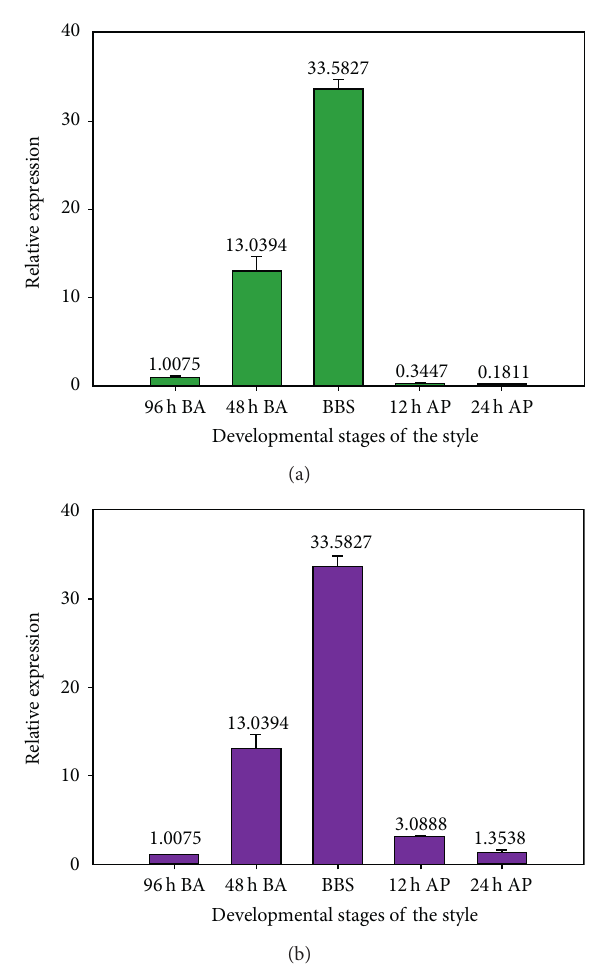
Figure 7: QPCR analysis for the PbS -RNase gene expression 26 detection during styles development in “Hongpisu.” (a) Relative -RNase gene in the style before and after self- expression of the PbS 26 -RNase gene in the pollination; (b) relative expression of the PbS 26 stylebeforeandaftercross-pollination.BA:beforeanthesis;BBS:bell balloon stage; AP: after